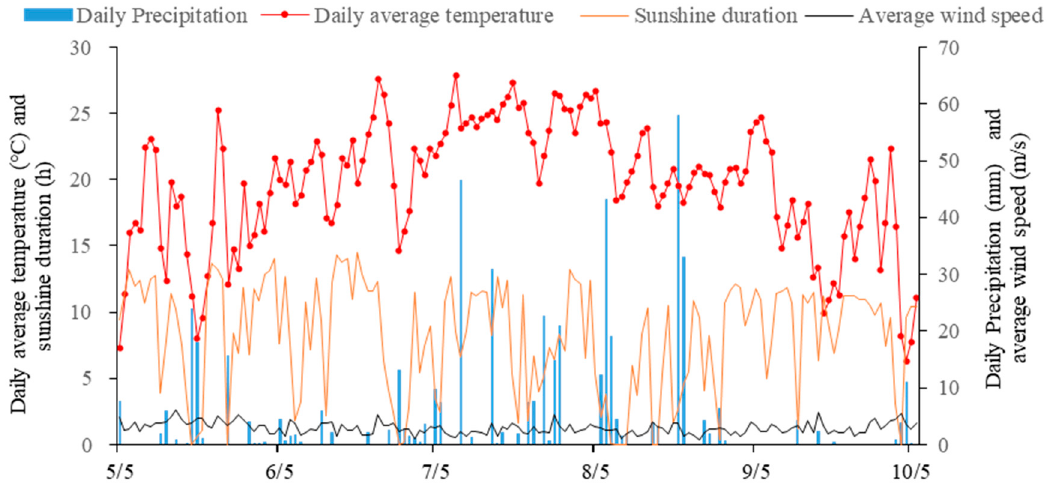
Figure 1. Meteorological conditions in the test area in the growing season from May to October. Table 1. Soil fertility and properties of